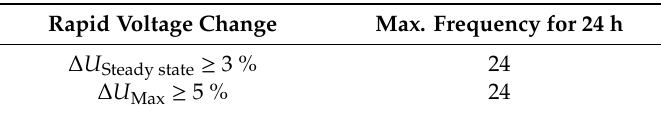
Table 1. Rapid voltage change [15].